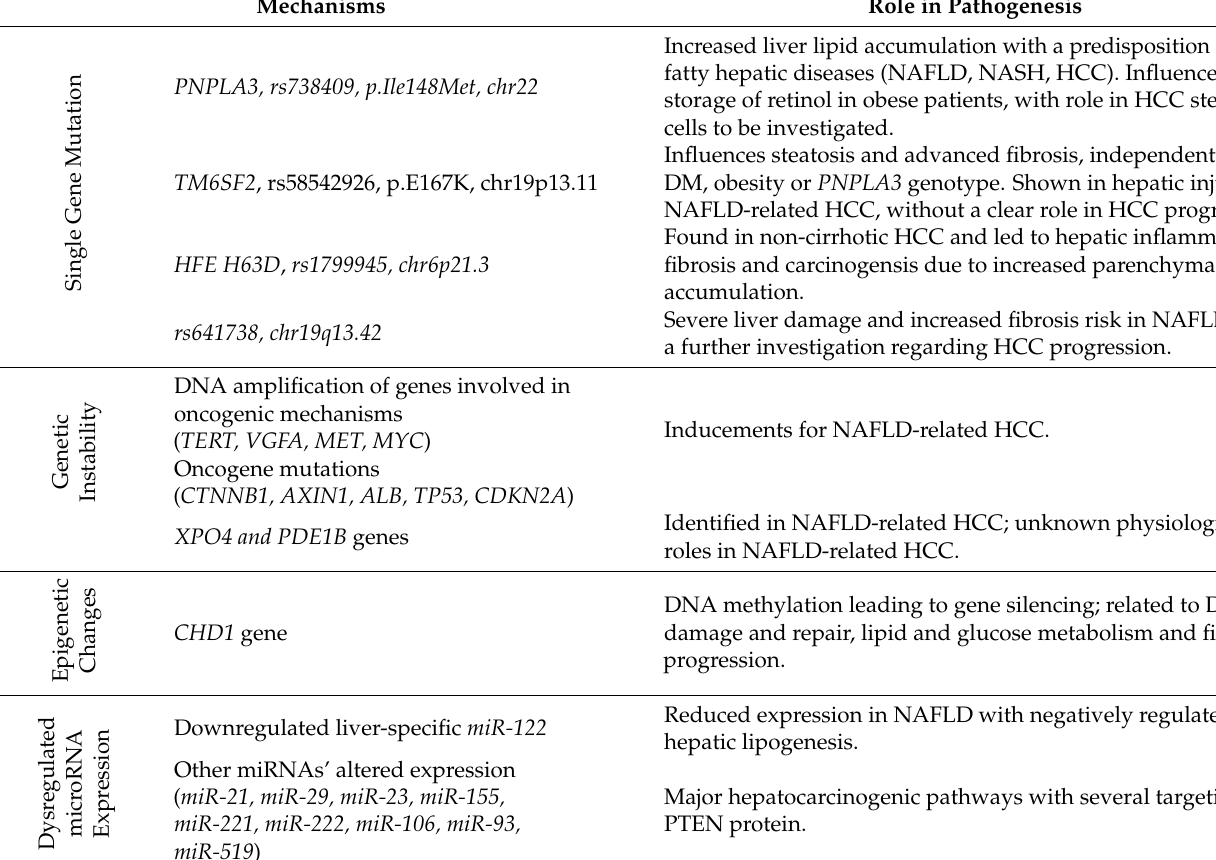
Table 2. Overview of the genetic mechanisms in non-alcoholic fatty liver disease (NAFLD)-related hepatocellular carcinoma (HCC) pathogenesis. Abbreviations: CDKN2A —cyclin-dependent kinase inhibitor 2A; CHD1 —chromodomain-helicase DNA-binding 1; CTNNB1 —catenin beta 1; DM—diabetes mellitus; HFE —hemochromatosis gene; MET —methionine; miRNAs—microRNAs; NAFLD—non-alcoholic fatty liver disease; NASH—non-alcoholic steatohepatitis; PNPLA3 —patatin- like phospholipase domain-containing protein 3; PTEN —phosphatase and tensin homolog deleted on chromosome